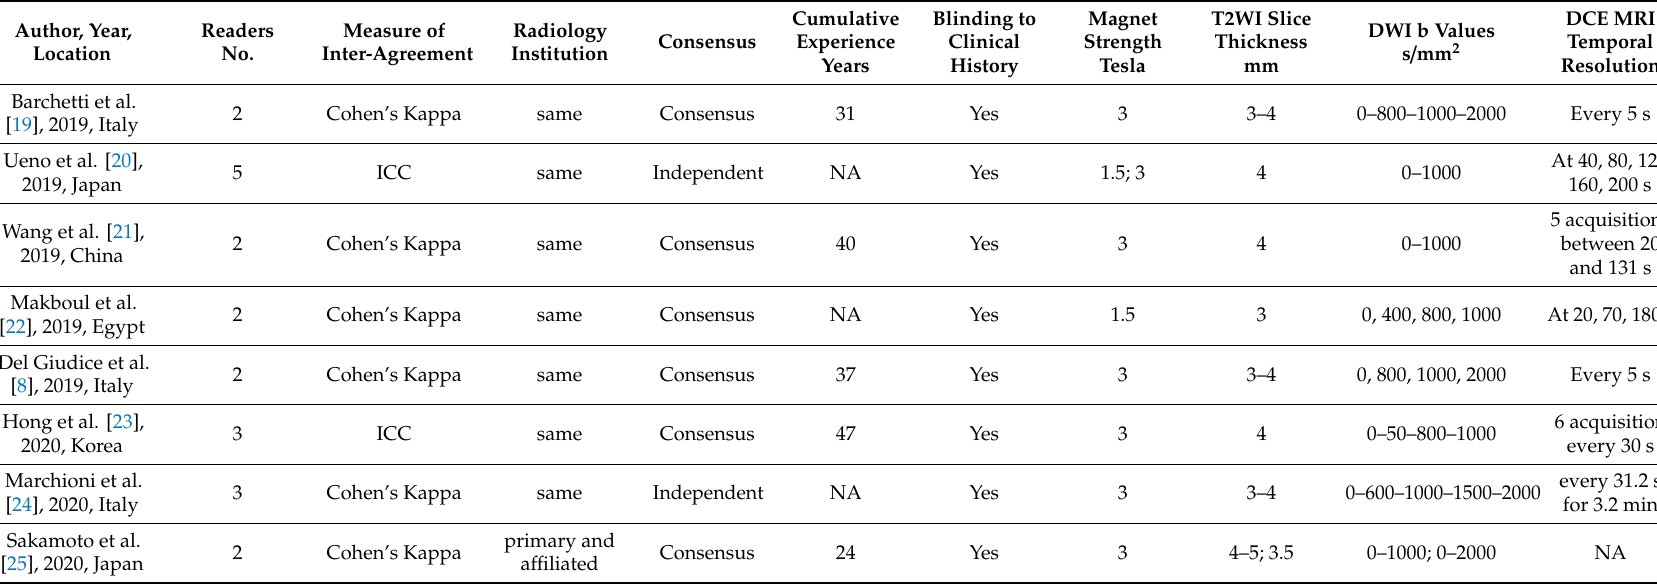
Table 2. Radiological and MRI-specific characteristics of the studies enrolled in the systematic review and meta-analysis. T2WI, T2-Weighted Imaging; DWI, Di ff usion Weighted Imaging; DCE, Dynamic Contrast Enhanced; ICC: interclass correlation coe ffi cient; NA, Not